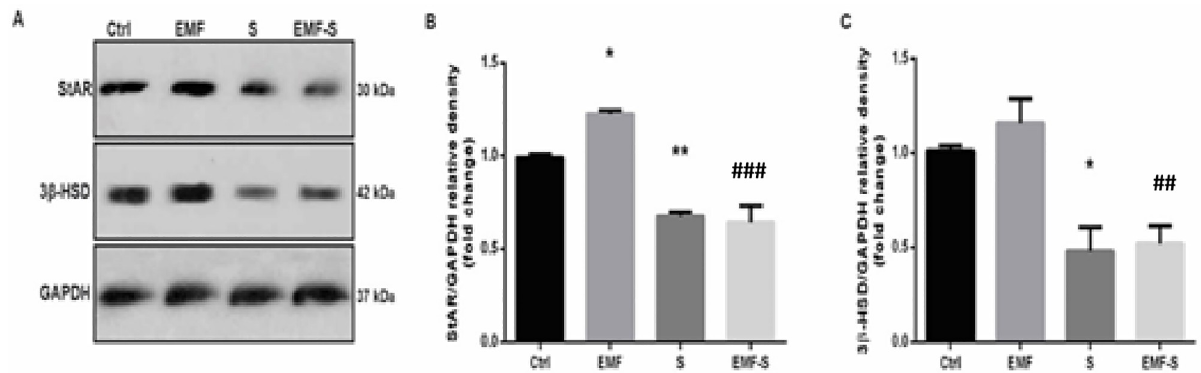
Fig 4. Effect of EMF exposure on steroidogenic acute regulatory protein (STAR) and 3B-Hydroxy steroid dehydrogenase (3 β -HSD) expression after prenatal stress. A. representative immunoblotting image of STAR, 3 β -HSD and GAPDH in different groups. Graphs show the quantified protein bands of (B) STAR and(C) 3 β -HSD normalized to GAPDH and were presented as fold of control. Data are shown as mean ± SEM (n = 6 per group). Two-way ANOVA, followed by Tukey’s posthoc test: � p < 0.05, �� p < 0.01 versus control group; ## P < 0.01, ### P < 0.001 versus EMF; ANOVA, analysis of variance; Ctrl, Control; EMF, Electromagnetic Field; S,